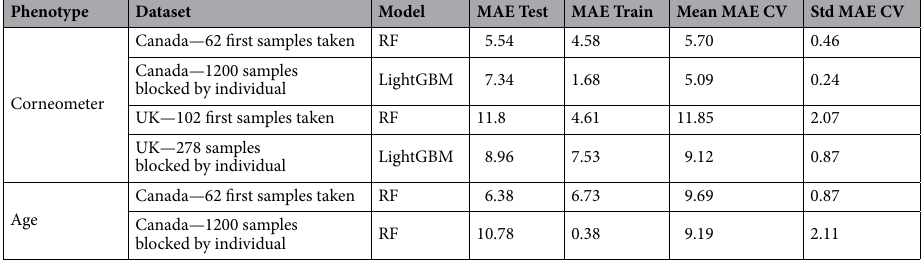
Table 2. Summary of predictive performance of the best ML models for regression tasks. Three ML models (RF, LightGBM, XGboost) have been evaluated on different subsets of the Canada cohort (62 samples taken from each subject at the first time point, and 1200 time series samples blocked by subject) and the UK cohort (102 samples taken from each subject at the first time point, and 278 times series samples blocked by subject). When applied to time series samples, the ML models have been tuned and trained blocking by individual, e.g., samples of the same subjects are not present both in the training and test datasets. The table reports the performances (mean absolute error (MAE) on training, testing and cross validation) of the best fine-tuned model per dataset and phenotype. Supplementary Table 1 shows the full list of predictive performances of all the ML models per dataset and phenotype.